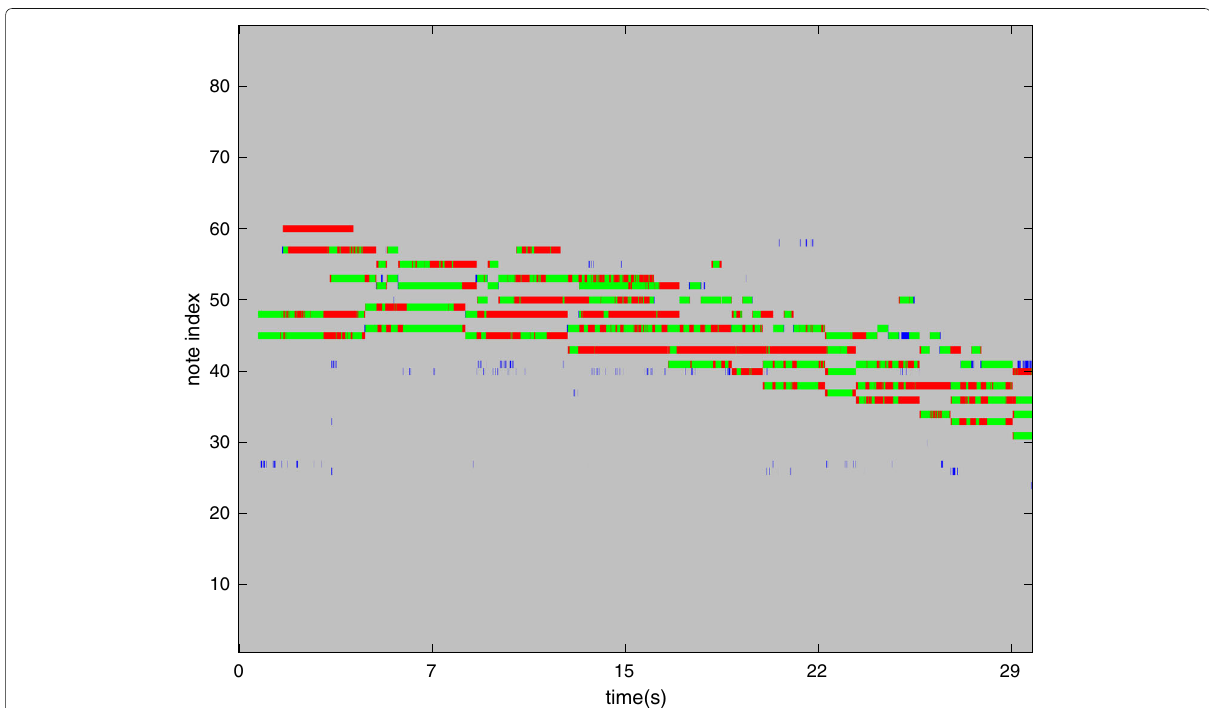
Fig. 17 AMT results of the first 30 s of “MAPS_MUS-deb_clai_ENSTDkCl” after the regularization of recurrent network. Some false positives are smoothed out. Note that since Gibbs sampling indices are selected randomly, not all frames have been updated by the recurrent network